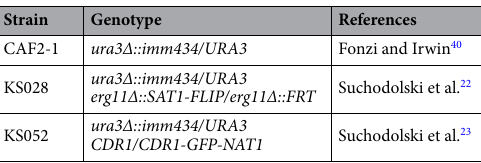
Table 2. C. albicans strains used in the